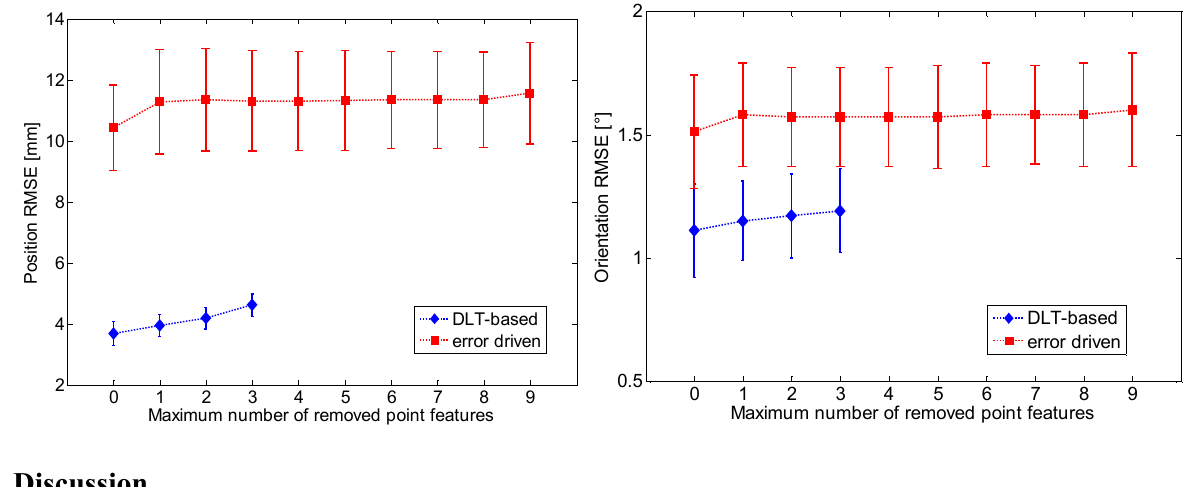
Figure 7. Error plots of the position and orientation RMSEs versus the number of image feature points that are removed at each iteration during processing by either the DLT-based EKF or the error-driven EKF (see